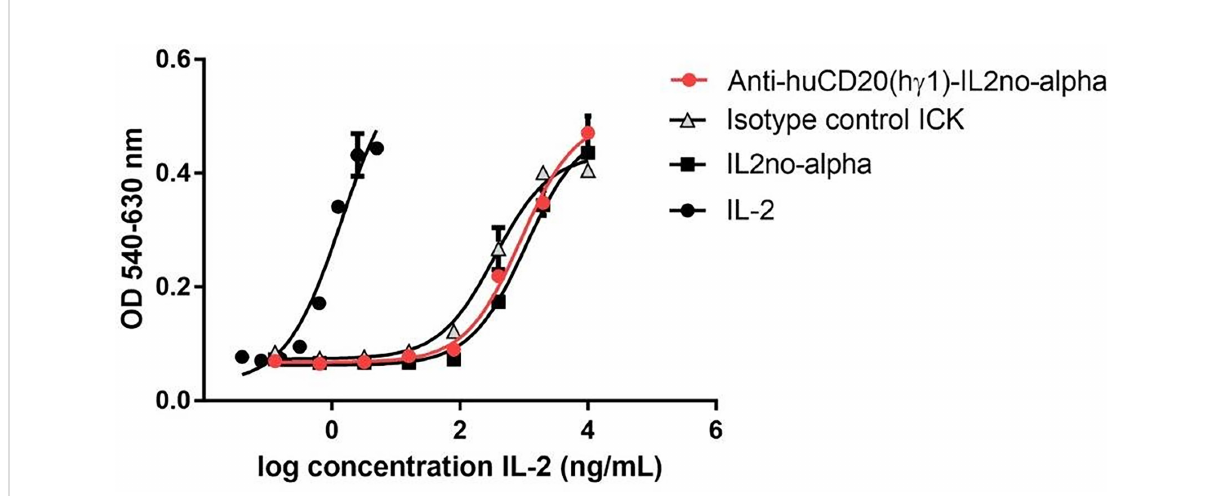
FIGURE 3 Cytokine-dependent functional effects of anti-huCD20(h g 1)-IL2no-alpha ICK. CTLL-2 cells were also cultured in presence of IL-2no-alpha mutein or with complete medium alone or in presence of IL-2, anti-huCD20(h g 1)-IL2no-alpha, or isotype-control ICK. After 48 h, cell proliferation was assessed by Alamar Blue and expressed as absorbance values (O.D. 540-630nm). Values represent mean ± SEM of cell cultures run in triplicates. At least two independent experiments were